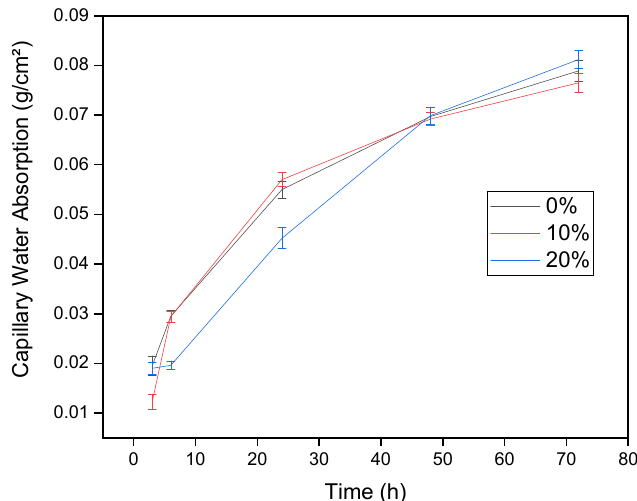
Figure 5. Results of density.